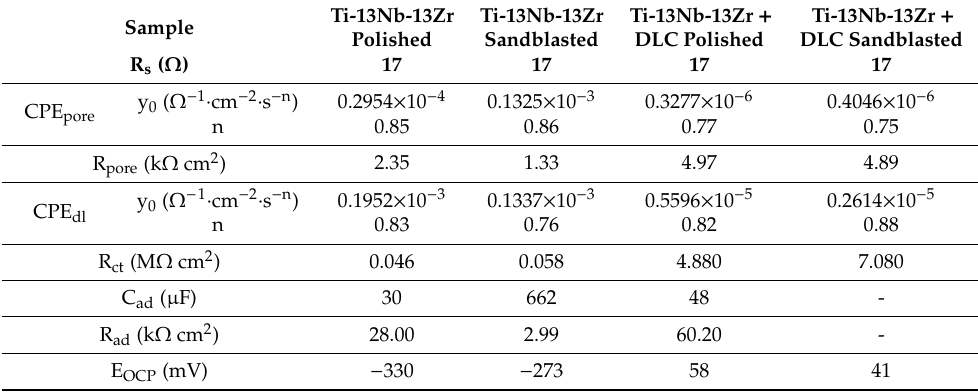
Figure 13. Equivalent electrical circuits of corrosion systems for: ( a ) sample in initial state, polished, ( b ) samples with the DLC coating and sample in initial state, sand-blasted.